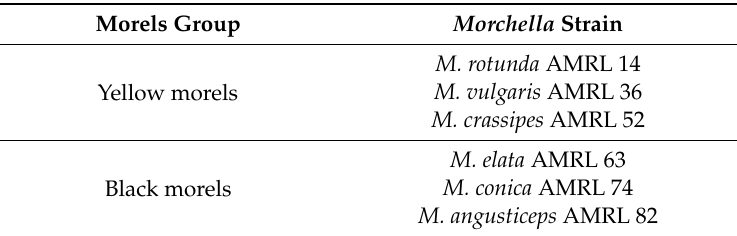
Table 1. Morchella strains used in the study. Morels